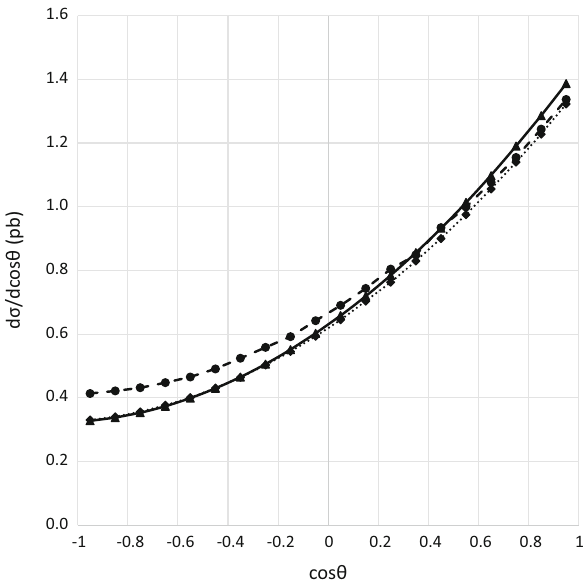
Fig. 4 The contribution of the two-loop diagrams to the ISR correc- tionsareshowasafunctionoftheCMenergies.Thedefinitionof δ 2 − loop is given in